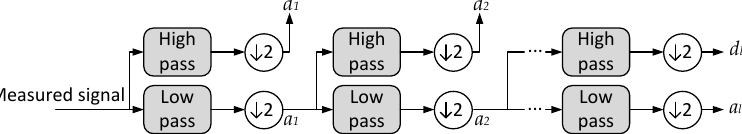
Figure 5. Multiresolution Signal Decomposition (MSD) of a measured signal.